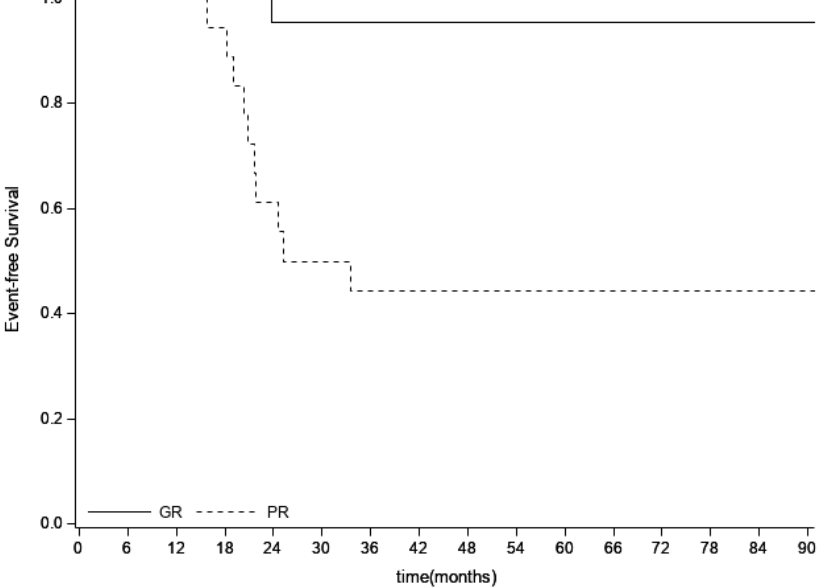
Figure 1. Event-free survival by primary tumor chemotherapy-induced histological necrosis in lung metastatic Ewing sarcoma patients. GR = histological good response, PR = histological poor response. The three-year and five-year PRFS resulted 78.1% (95%CI = 61–88.4) and 70.5% (CI = 56.3–80.8), respectively. Among these patients who had complete remission of lung lesions, no event occurred in the subgroup with good histological response of the primary tumor while those with poor histological response showed a higher risk of pulmonary relapse (X 2 = 10.85, p =